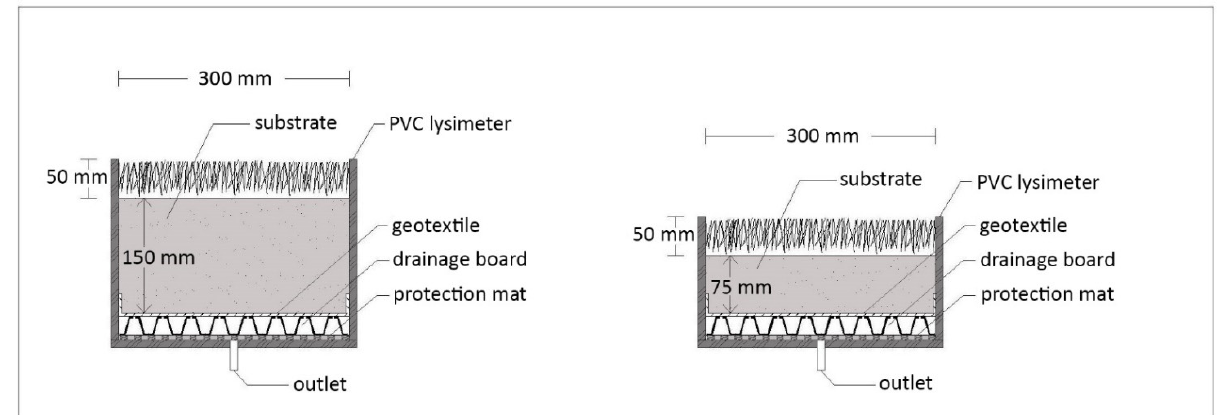
Figure 1. Construction detail of the experimental lysimeters indicating the different layers of the extensive green roof system in two substrate depths (7.5 cm and 15 cm).